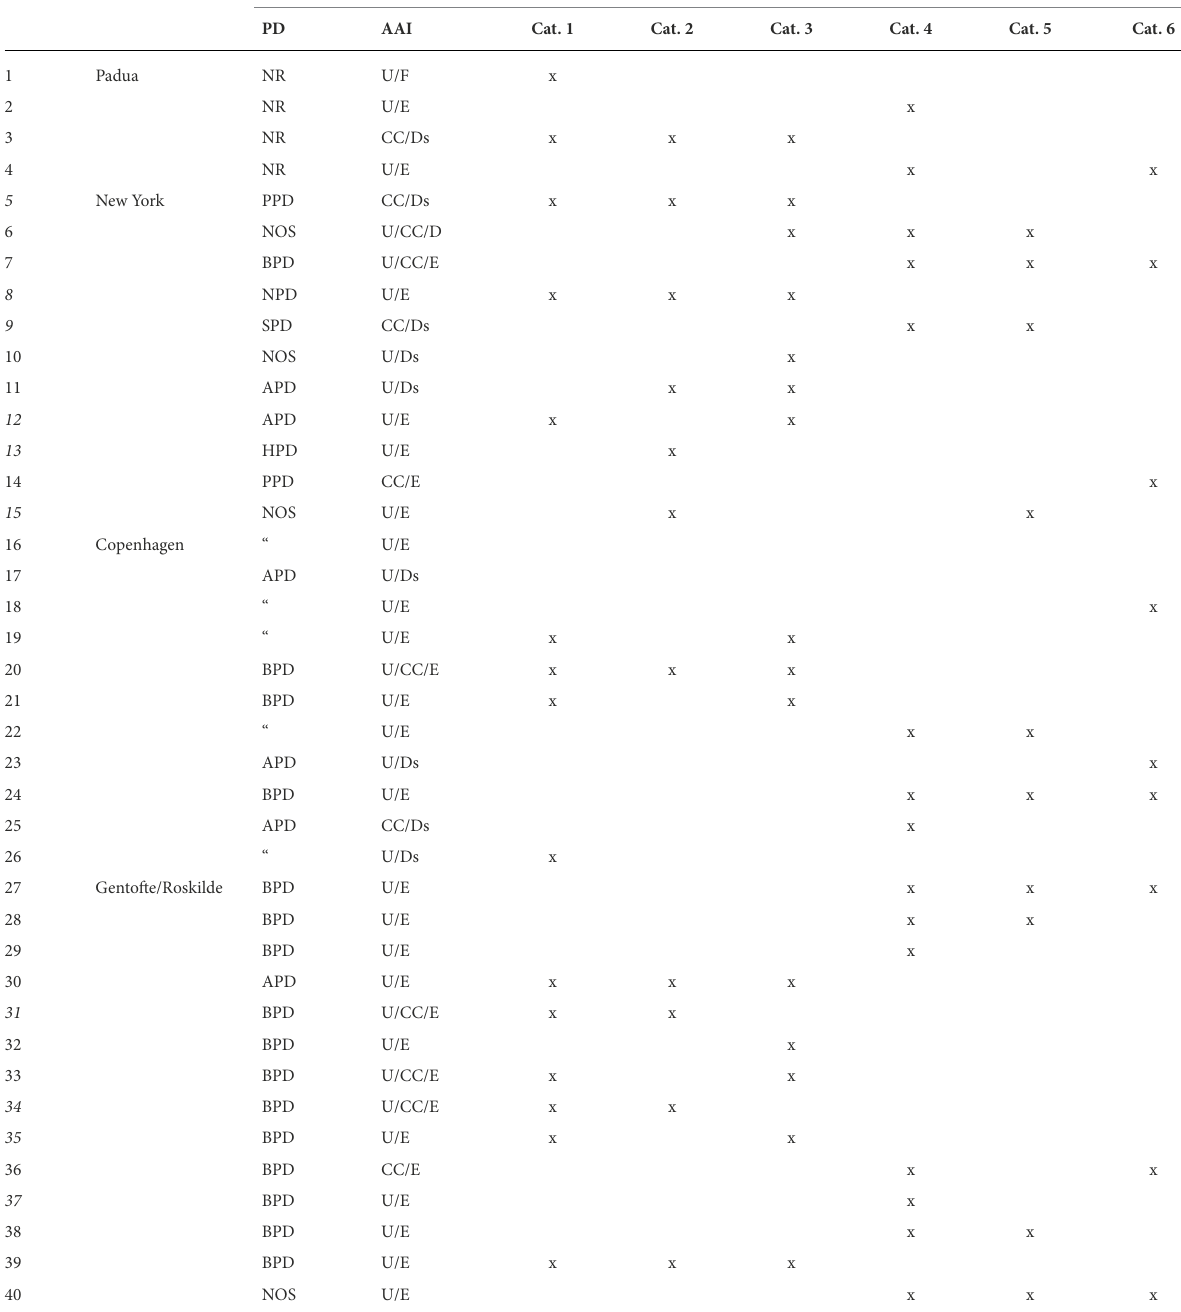
TABLE 1 Contingency table illustrating the categories of indicators represented in